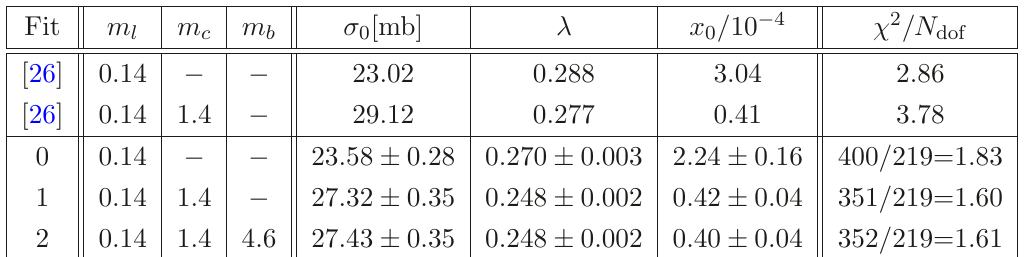
Table 1 . Fit results to the HERA data for Q 2 10 GeV 2 with N p = 222 points, using the dipole ≤ cross section (2.6). Quark masses are given in units of GeV. χ 2 /N dof computed with the parameters from [26] are given in the first two rows. The parameters of Fit 2 are used for further